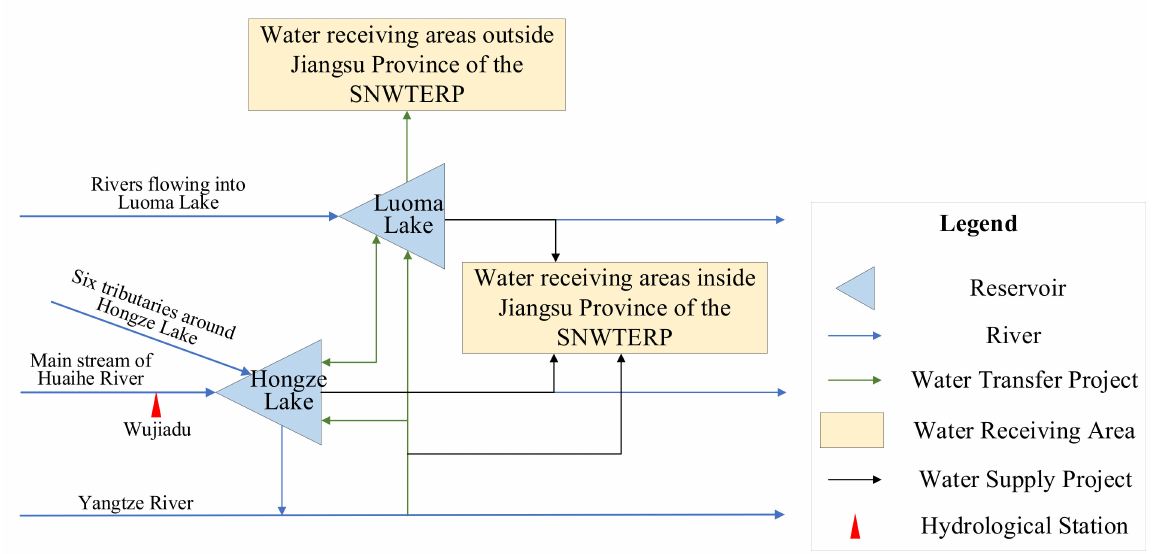
Figure 2. The simplified network diagram of the water supply